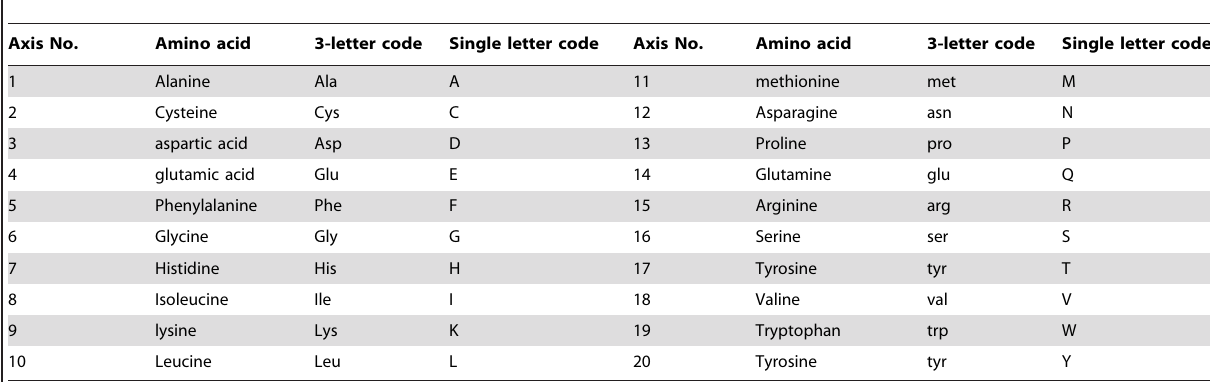
Table 1. Assignment of axis to individual amino acids.